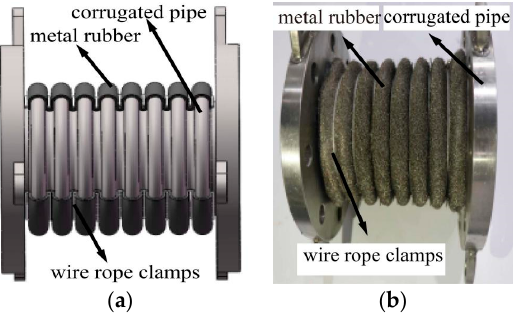
Figure 1. ( a ) Schematic diagram of the coated damping structure for metal rubber of bellows; and ( b ) physical picture of coated damping structure for metal rubber of bellows.